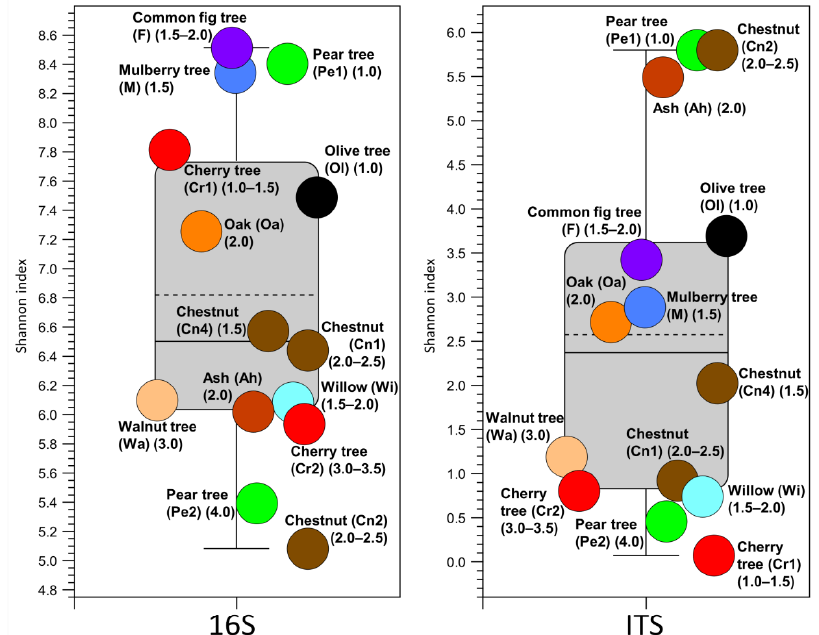
Figure 1. Shannon index at OTU level for bacteria (16S, left) and fungi (ITS, right). Numbers indicate the Swedish National Forest Inventory (NFI) level of wood decay (1, low level of decay; 4, high level of decay), whereas the colours show the tree species. The dashed and full lines show the mean and median values, respectively. The box border percentile is 25, and the whiskers range factor is 1.5.